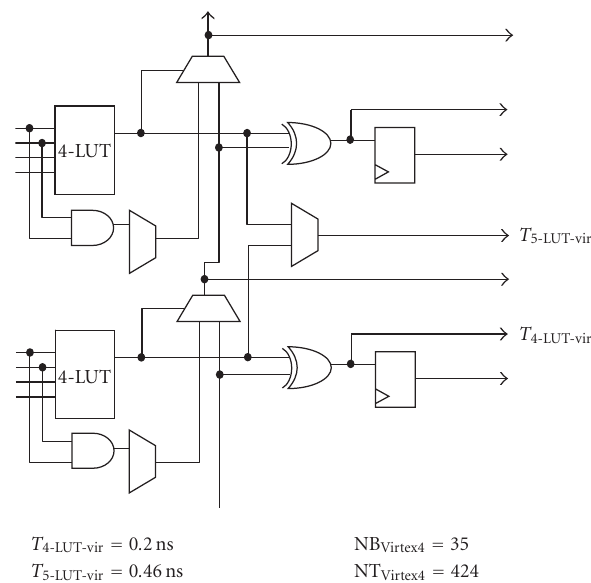
Figure 11: Heterogeneous LUT structures with carry chain.